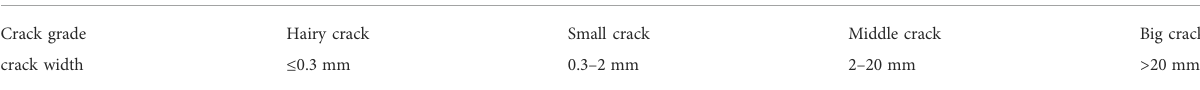
TABLE 2 Quantitative evaluation criteria of lining cracks.